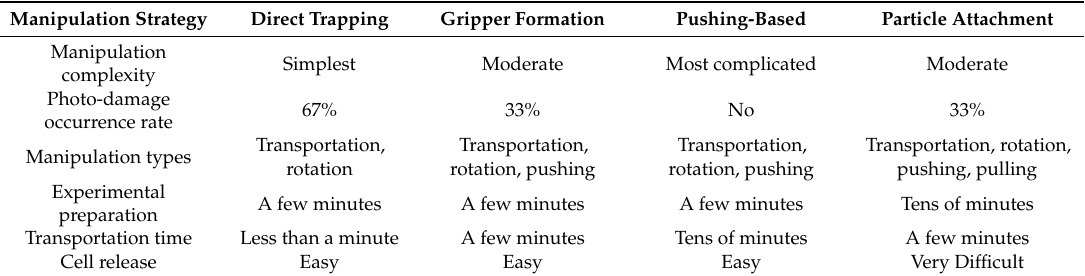
Table 1. Comparison of cell manipulation